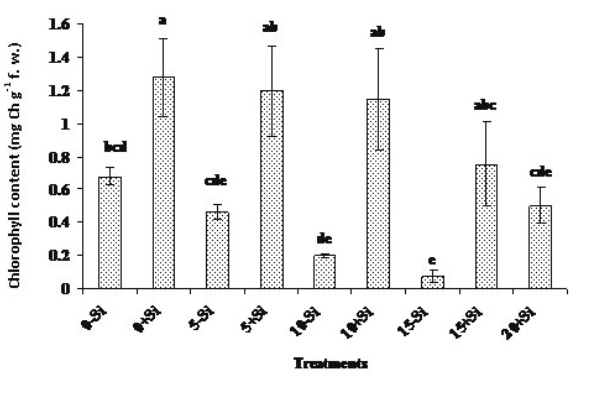
Fig. 1 - Effects of different salinity and Si levels on chlorophyll content of Poa pratensis after 45 days. 0: control, 5, 10,